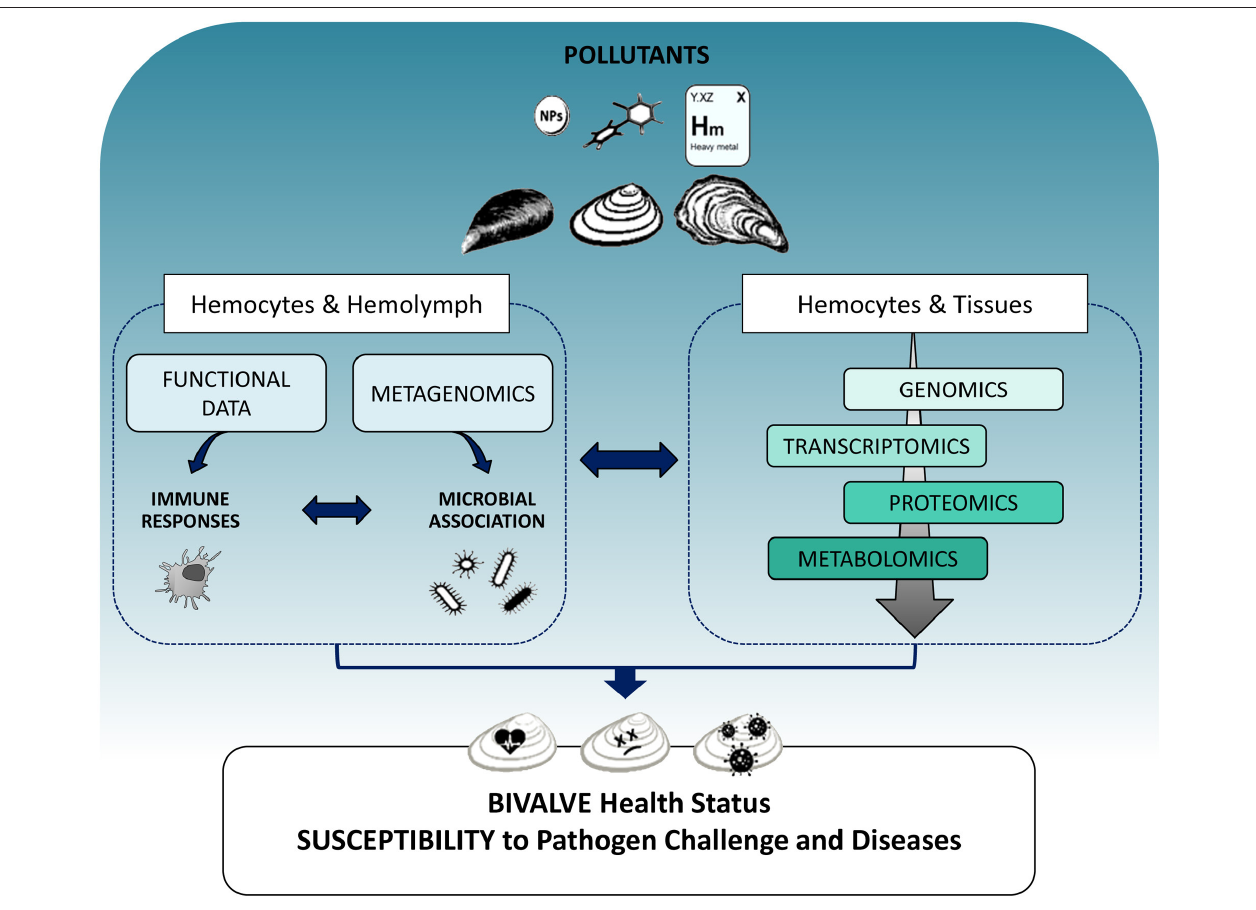
FIGURE 1 | Schematic overview showing the integration of different -omics approaches in evaluating the impact of pollutants on the immune responses of bivalves and their consequences on organism health. Left: The effects of different contaminants (heavy metals, organic xenobiotics, and nanoparticles) can be evaluated on the main components of the immune system, hemocytes, and hemolymph plasma, determining functional immune responses as classical immune biomarkers. The application of metagenomics to hemolymph samples can provide an estimation of how contaminant exposure may shape the interactions between innate immune defenses and the associated microbial communities. Right: Different -omics tools approaches applied to both hemocytes and tissues can reveal perturbations of immune responses as changes in gene and protein expression networks and metabolic profiles related to immune processes at cellular and tissue level and can identify immune targets for different classes of pollutants. The overall information will help understanding how contaminant exposure can affect the capacity of different bivalves to cope with pathogen challenge, thus increasing their susceptibility to disease, with possible consequences on the health status of natural populations and aquacultured